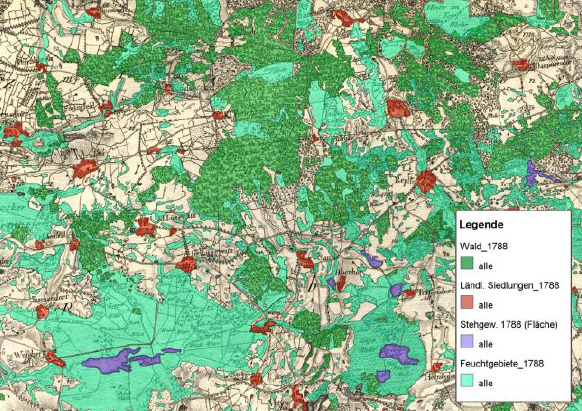
Figure 6: Captured forests, settlement and water areas within the time slice 1788.